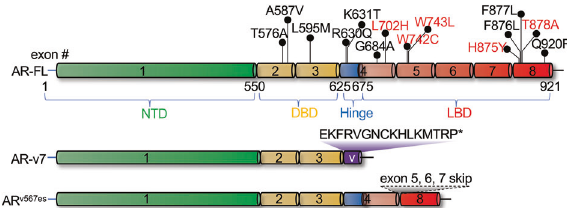
Fig. 3 Recurrent AR mutations and alternative splicing variants contribute to AR antagonist resistance. Mutations in red are the most prevalent mutations in patients [74, 75], while those in black are enzalutamide- and apalutamide-resistant mutations [76, 77]. AR- v7 lacks exons 4/5/6/7/8 and differs by 16aa at the C-terminus compared with AR-FL. Exons 5/6/7 are excluded in AR v567es compared with